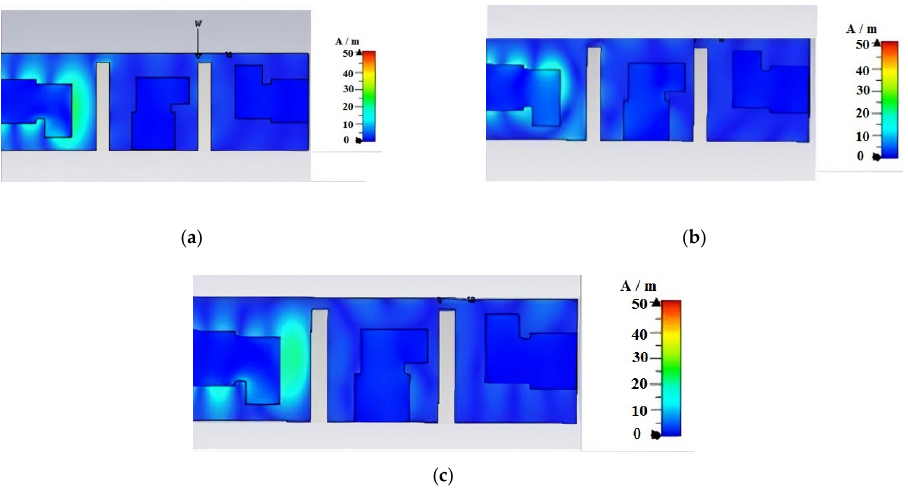
Figure 5. The flow of current on the surface by exciting port 1 and keeping other ports terminated with a match load ( a ) 26 GHz ( b ) 30 GHz ( c ) 35 GHz.